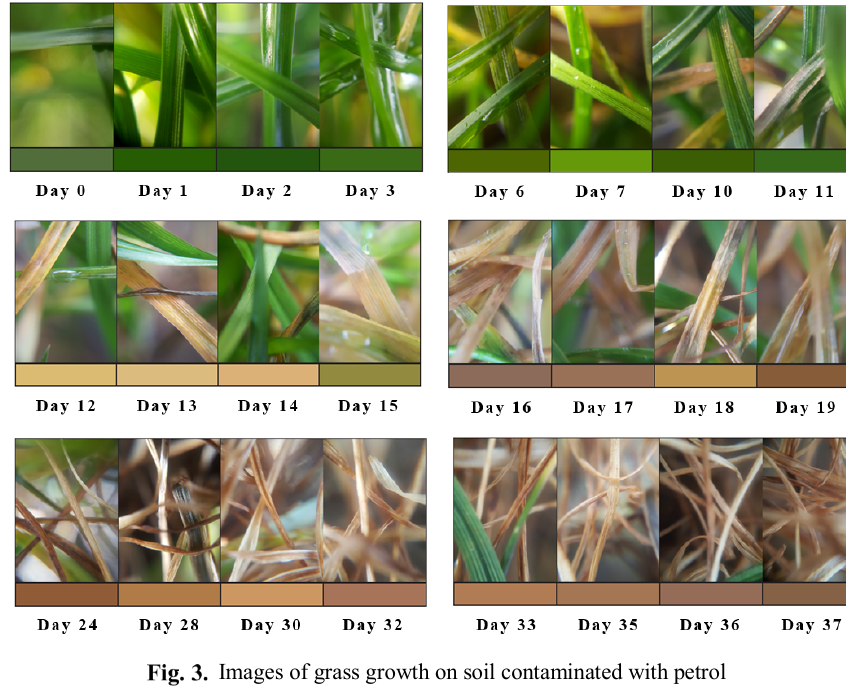
Images of grass growth on soil contaminated with petrol